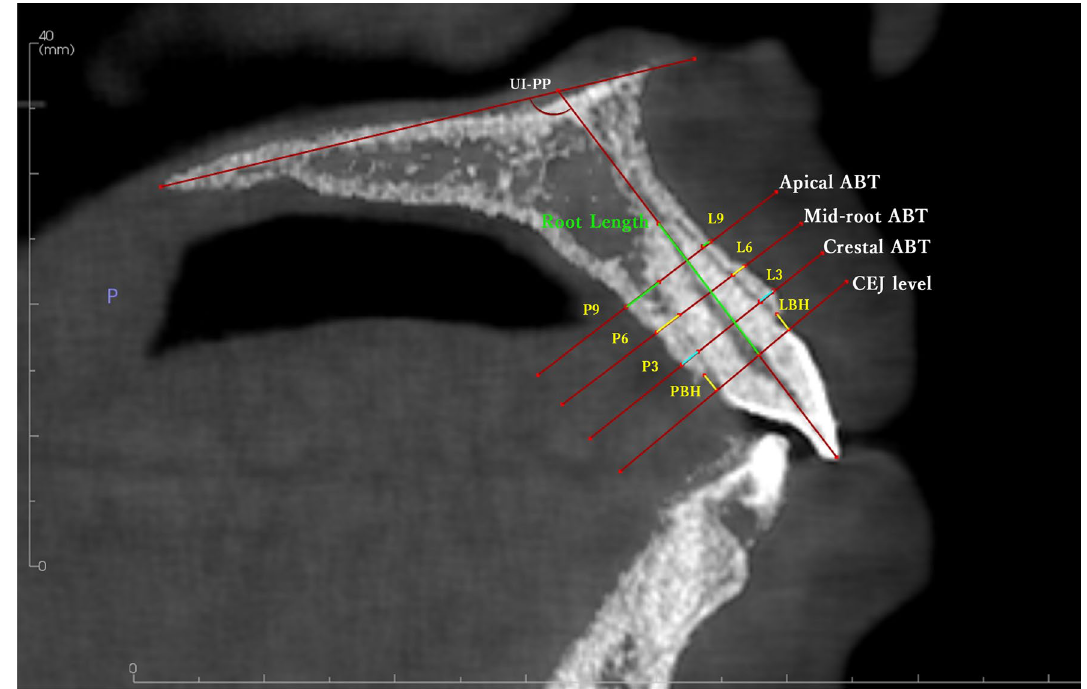
Fig. 1 Reference lines and measurements in sagittal view for upper central incisor. ABT: alveolar bone thickness, LBH: labial bone height, PBH: palatal bone height, UI‑PP: upper incisor to the palatal plane angle.